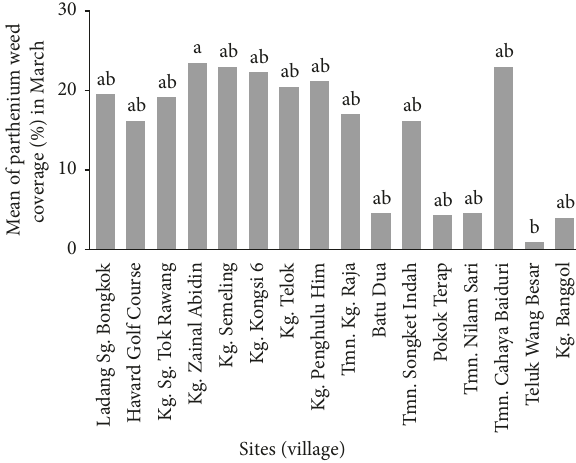
Figure 4: Parthenium weed density of different villages of Kuala Muda in March 2015. Kg. � Kampung, Tmn. � Taman, and Sg. � Sungai. Dissimilar small letters on bars indicate a significant difference.